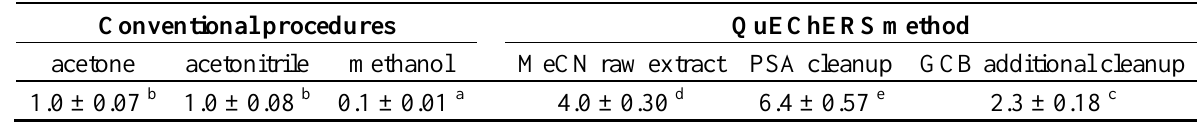
Table 3. Fucoxanthin content (µg/mL) in the conventional extracts (acetone, acetonitrile, methanol) and in the extracts obtained with the QuEChERS method (acetonitrile raw extract, PSA cleanup, GCB additional cleanup) after light